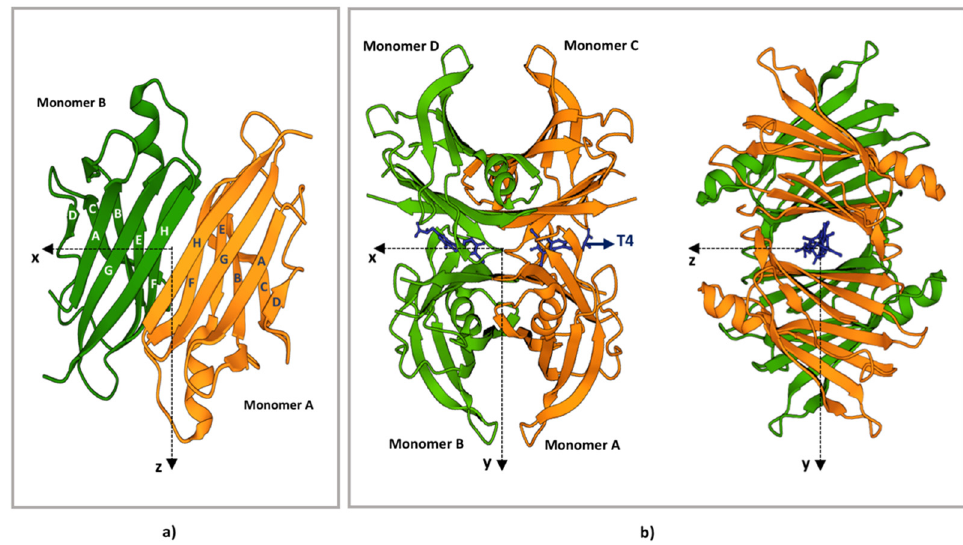
Figure 1. TTR structure. ( a ) Ribbon diagram of the AB dimer interface ( b ) Ribbon diagram of the TTR tetramers. The X-axis passes through the T4 binding channels, which are formed at the interface of monomers D-B and C-A. The halogen binding pockets (HBP) are shaped by the following amino acids: HBP1, Lys15-Leu17-Thr106-Val 121; HBP2, Lys15-Leu17-Ala108-Ala109-Leu110; HBP3, Ser117-Leu110-Thr119-Ala108. T4 is represented in blue. The figure has been produced using “www.rcsb.org”web site (protein ID code 1QAB), access date 22 June 2022.